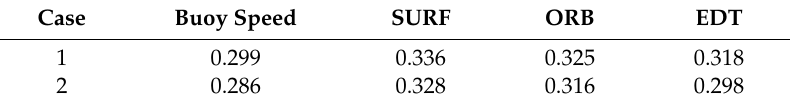
Table 3. Comparison of the average of sea ice drift speed (km /